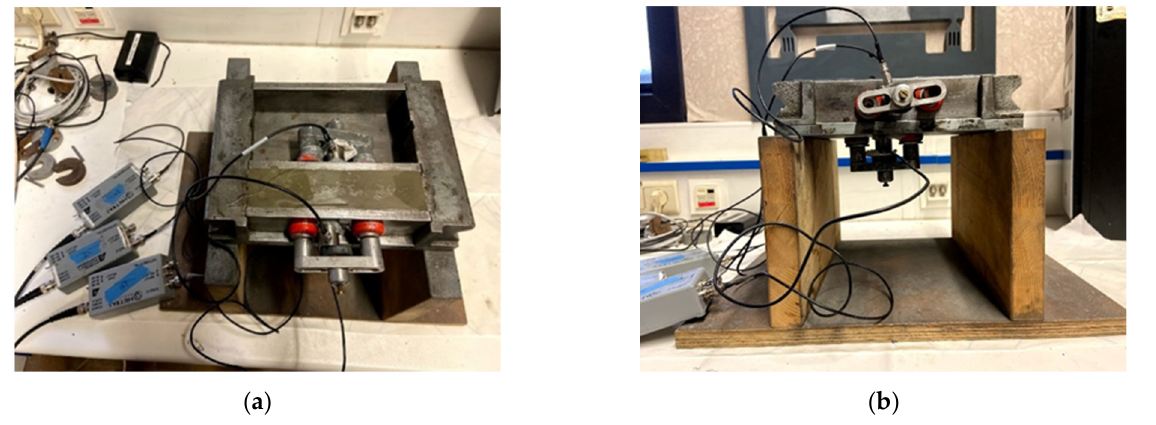
Figure 1. Acoustic emission set-up for fresh monitoring: ( a ) top view showing two opposing sensors attached to the longitudinal walls by means of magnetic holders and ( b ) side view showing the bottom sensor (reprinted from [20]).